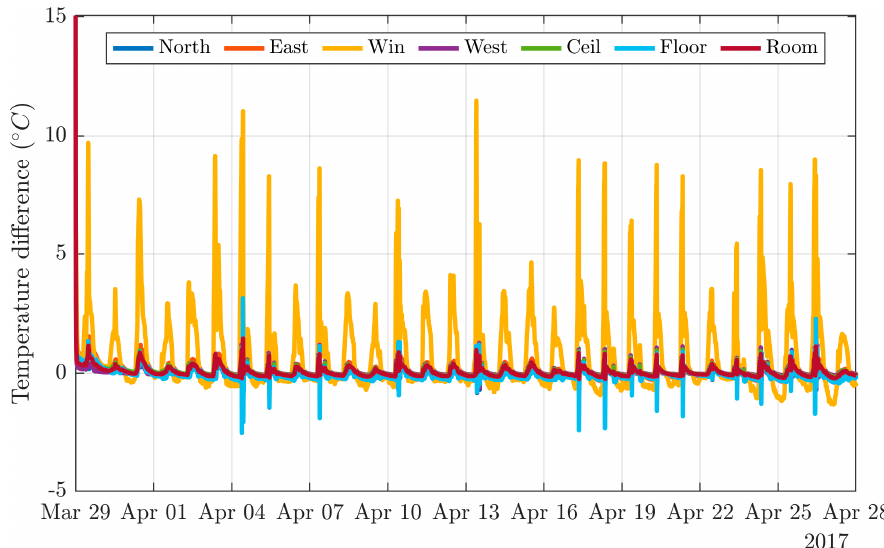
Figure A4. The deviation between the TRNSYS results and the RC model results.